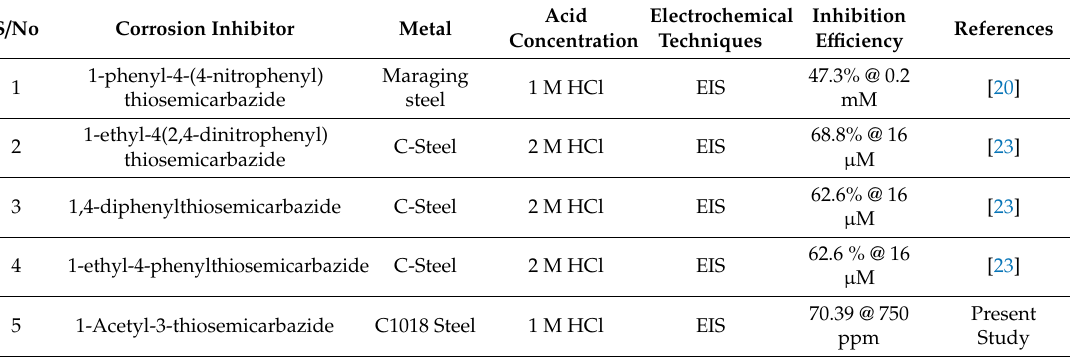
Figure 8. Comparison of the Inhibition efficiencies obtained from the different electrochemical Table 5. Comparison of the performance of the proposed corrosion inhibitor with similar inhibitors already reported in the literature.